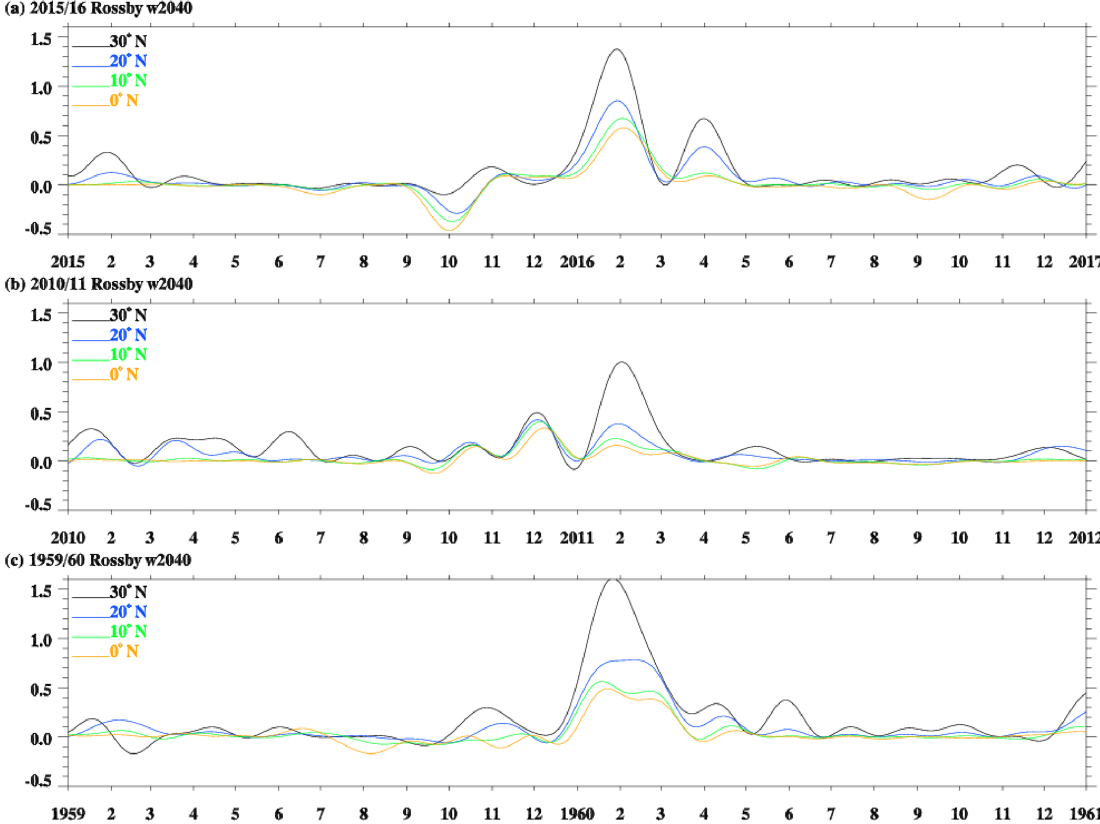
Figure 8. The temporal variation in Rossby w2040 (with wavenumber 1) horizontal momentum flux anomaly at 0 ◦ N (orange lines), 10 ◦ N (green lines), 20 ◦ N (blue lines), and 30 ◦ N (black lines) in 2015/2016, 2010/2011, and 1959/1960 at